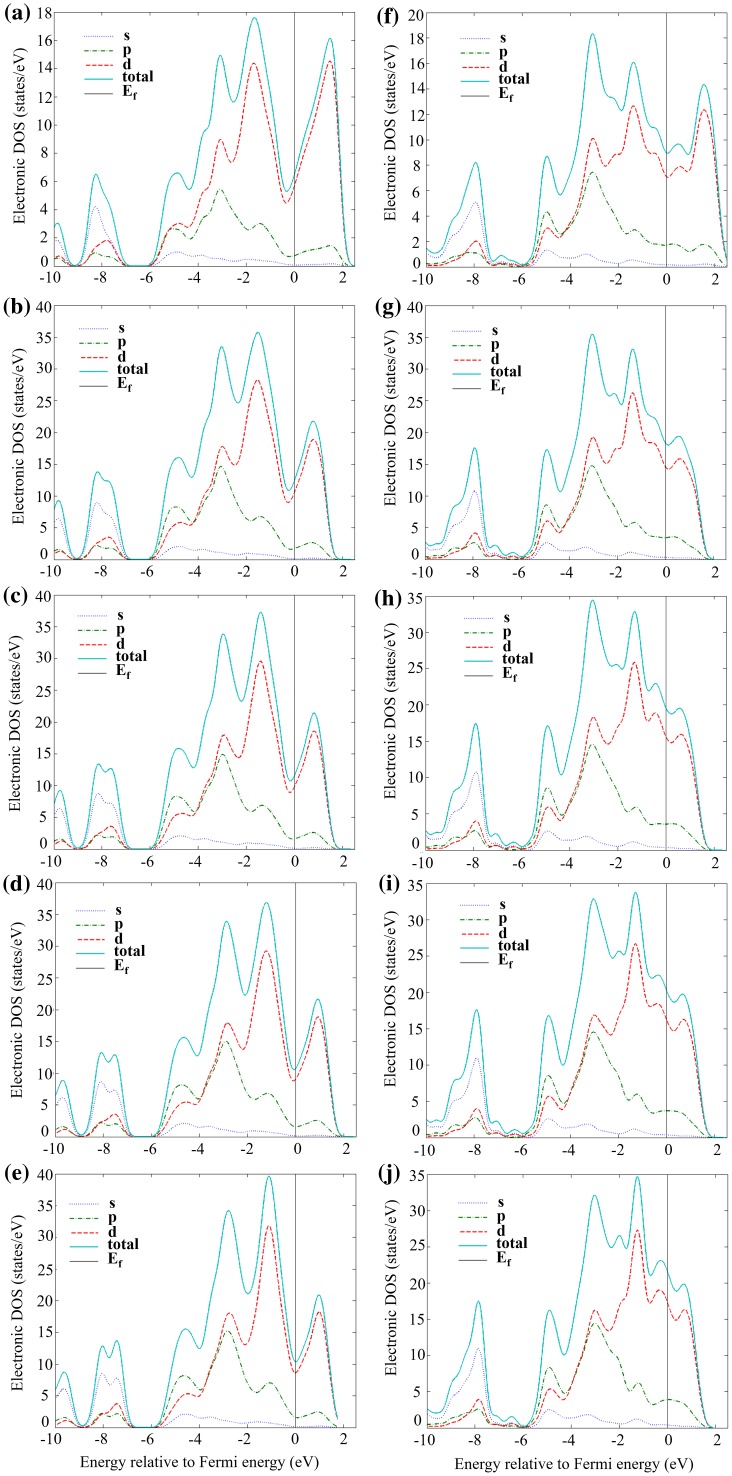
Partial and total density of states of (a) αNb5Si3, (b) αNb19TiSi12, (c) αNb18Ti2Si12, (d) αNb17Ti3Si12, (e) αNb16Ti4Si12, (f) βNb5Si3, (g) βNb19TiSi12, (h) βNb18Ti2Si12, (i) βNb17Ti3Si12 and (j) βNb16Ti4Si12
.